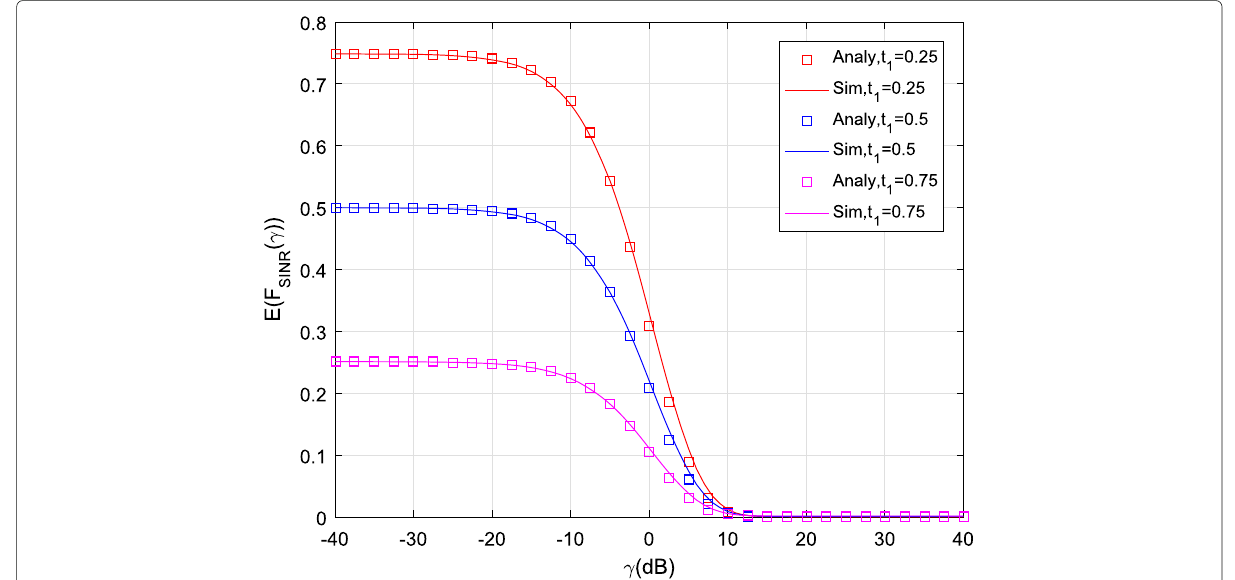
Fig. 15 CCDF of the SINR of the hybrid scheme for the typical MT with (cid:5) = 1, t ( 1 ) / t ( 2 ) = 9 dB, p max → ∞ , and i 0 = − 120 dBm